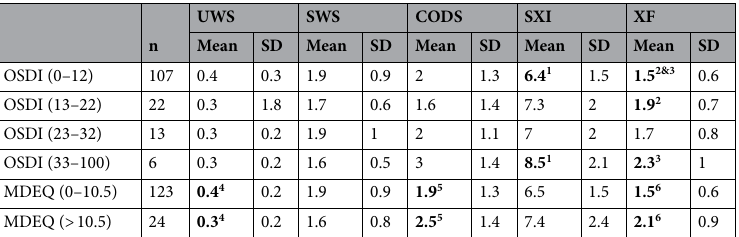
Table 4. Comparison of oral parameters between subgroups of OSDI Ocular Surface Index questionnaire and MDEQ McMonnies Dry Eye questionnaire respectively. ANOVA with Bonferroni Post Hoc test. Bold represents level of significance: p < 0.05. 1 SXI Summated Xerostomia Inventory, OSDI 0–12 vs. OSDI 33–100, p = 0.016. 2 XF xerostomia frequency, OSDI 0–12 vs. OSDI 13–22, p = 0.032. 3 XF, OSDI 0–12 vs. OSDI 33–100, p = 0.023 Mann–Whitney U test of relationship MDEQ ≤ 10.5 vs. MDEQ > 10.5 and oral parameters. 4 UWS